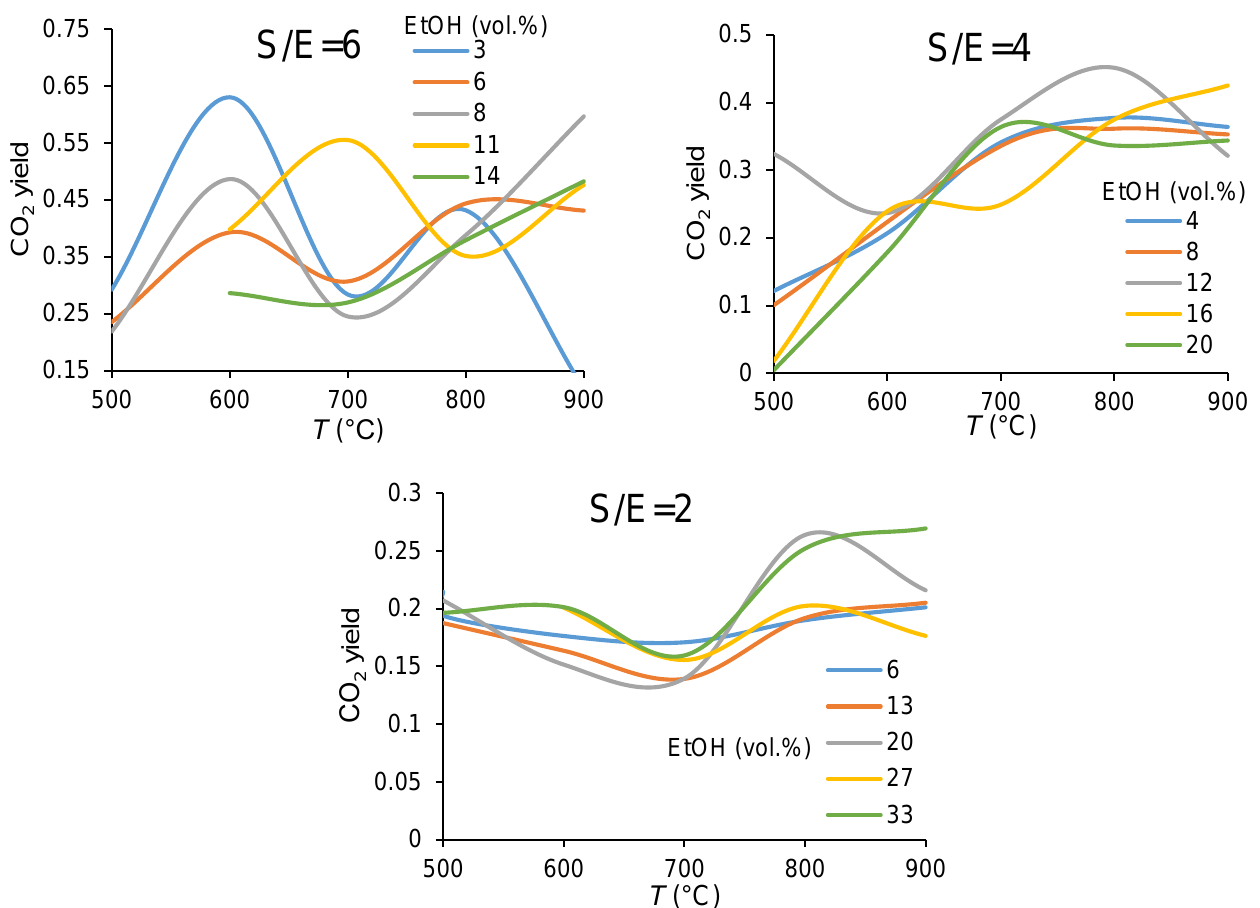
Figure 5. Temperature dependencies of carbon dioxide yield in ethanol steam reforming in CMR at the different ethanol concentrations (in vol. %) and the steam-to-ethanol molar ratios in the feed.